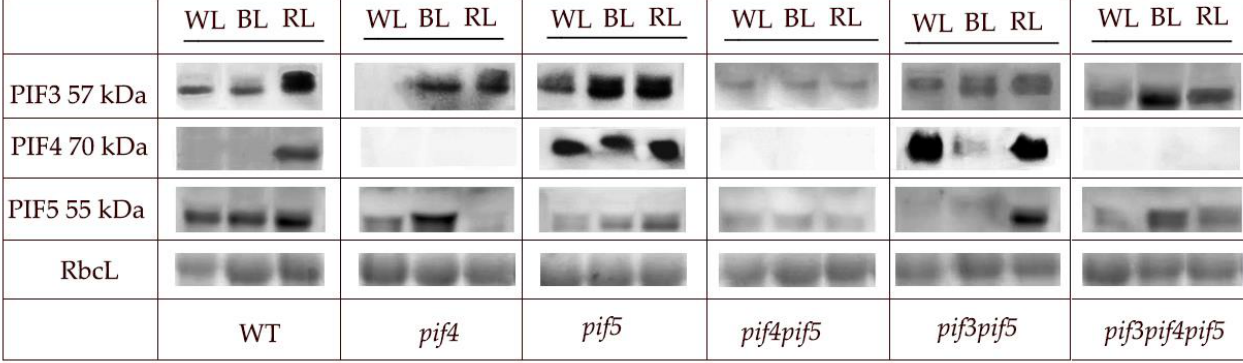
Figure 5. Immunoblot analyses of proteins extracted from rosette leaves of A. thaliana pif mutants grown under light with different spectra (anti-PIF3 (AS163954), anti-PIF4 (AS163955) and anti-PIF5 (AS122112) antibodies. The Ponceau S-coloured level of RbcL protein is shown as a loading control.